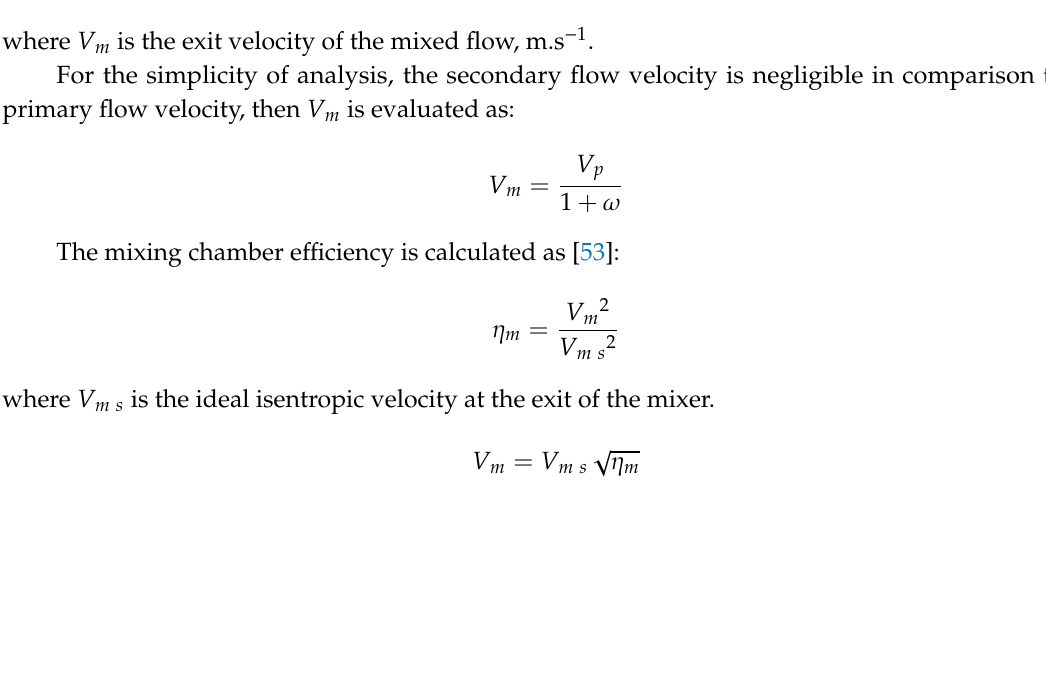
Table 2. T hermodynamic and energy balance equations for CERC and NTRC.